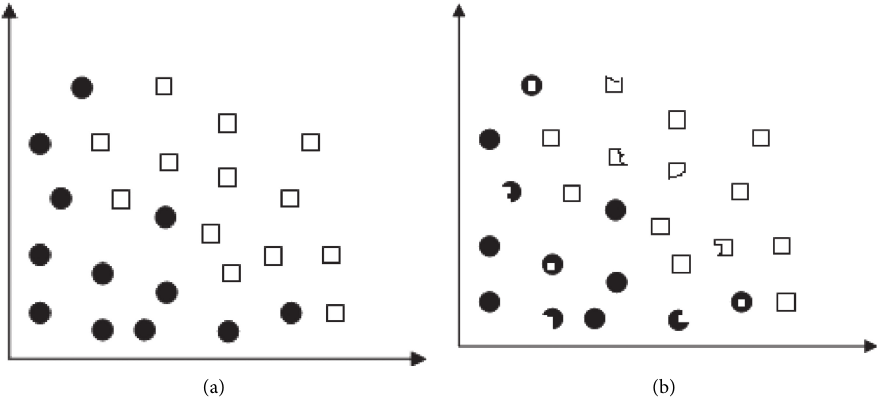
Figure 1: Comparison of data set. (a) Complete data set collection. (b) Missing data set